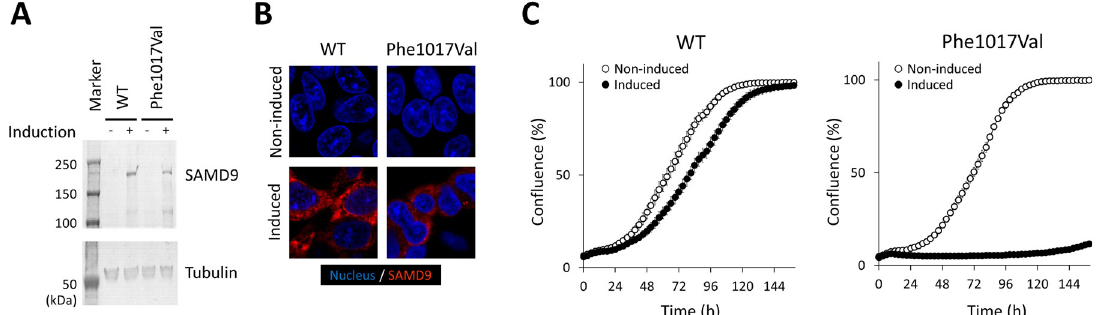
Fig 3. Phe1017Val-SAMD9 was characterized in vitro with inducible stable HEK293 cells. A, Western blot analysis showed comparable protein expression levels between wildtype (WT)-SAMD9 and Phe1017Val-SAMD9. B, Intracellular localization of SAMD9 proteins, evaluated with the immunofluorescence technique, were similar between WT and the mutant. C, Induced expression of WT-SAMD9 resulted in mild growth restriction ( left panel ), whereas expression of Phe1017Val-SAMD9 caused profound growth restriction ( right panel ), which is a characteristic of MIRAGE syndrome-associated SAMD9 variants.